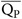
Schematic describing the preload-based Starling-like control, A) Frank-starling curve, B) returning the operating point back to CL.CL, Control line of the pump (Frank-Starling curve); S1, original system state corresponding to the original left ventricular end-diastolic pressure (PLVED); S2 and S3, changed system states. PLVED, Left Ventricular End Diastolic Pressure; QP-, mean pump flow; PLVEDm, measured (actual) left ventricular end diastolic pressure provided by the model; QPm-, measured (actual) mean pump flow provided by the model; White circle, position of operating point (current combination of PLVED and QP-) before a change of state; Grey circles, position of operating points after changes in states; Black circles, position of operating points upon arriving at the new steady state located at the intersection between the control line and the new system line. The controller drives the changes in the operating points along the path indicated by the arrows along the new system line.